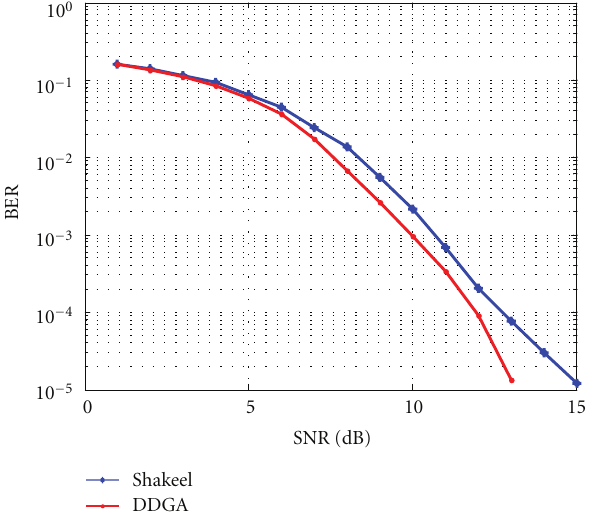
Figure 27: Performances of DDGA, and Shakeel algorithms for BCH (63,51,5) code over RC.